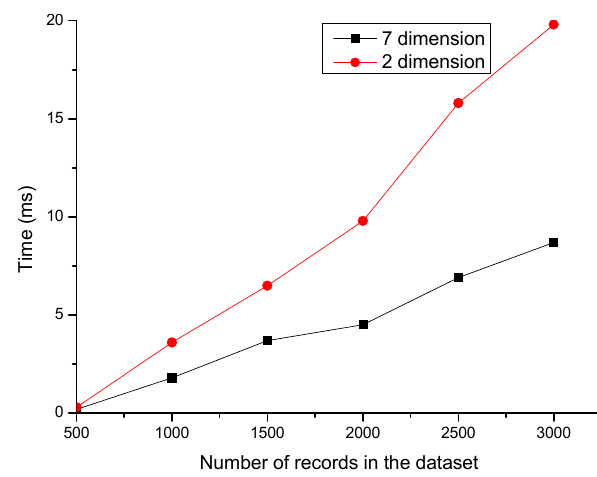
Figure 5. The Relationship between Complexity and Data Dimension.